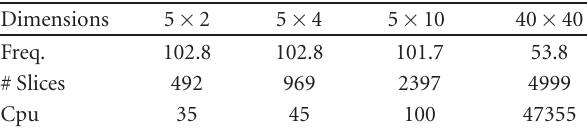
Table 2: Sizing matrix impact over frequency, resources, and synthesis time.